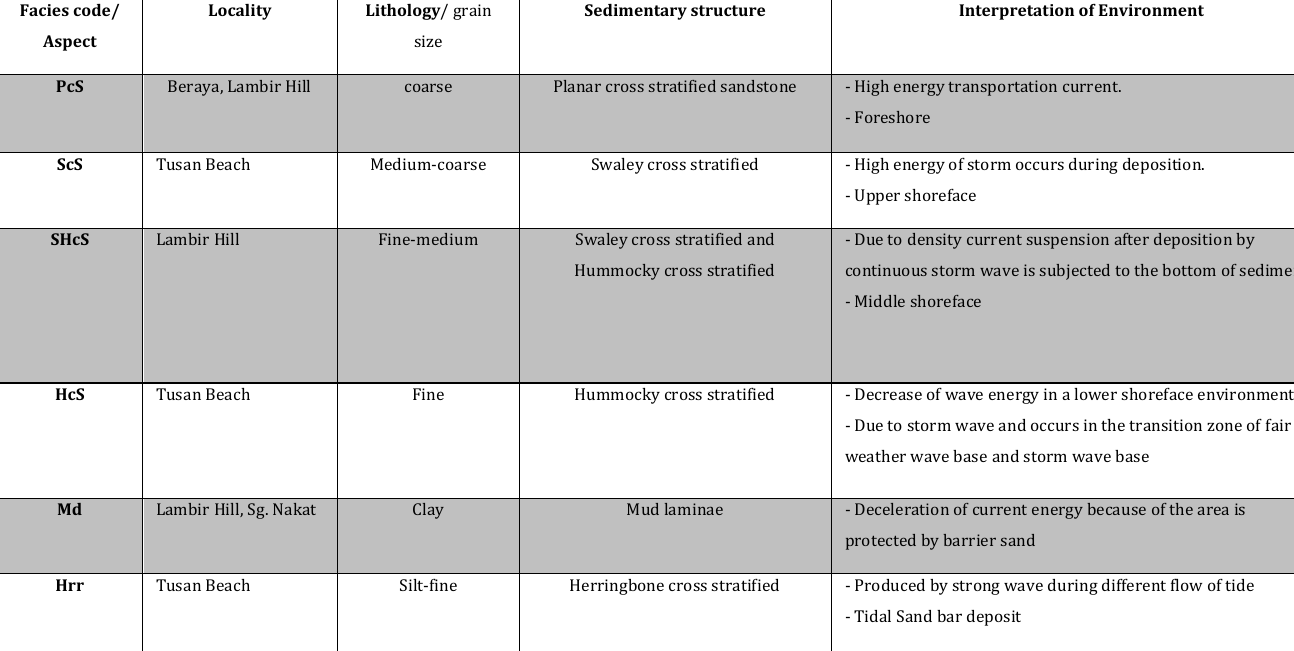
Table 1: Facies attribute to wave and tide dominated